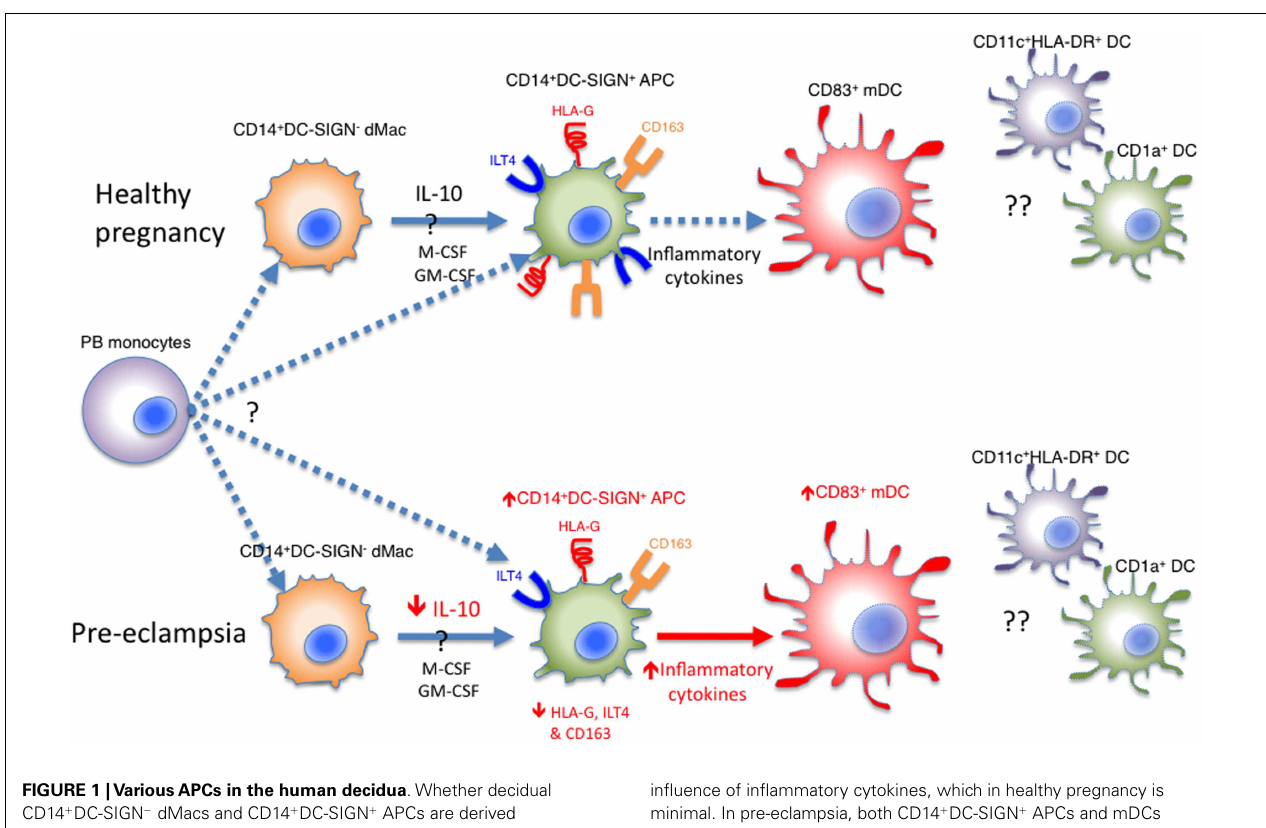
FIGURE 1 |VariousAPCs in the human decidua .Whether decidual CD14 + DC-SIGN − dMacs and CD14 + DC-SIGN + APCs are derived independently from peripheral blood (PB) monocytes is unknown. Alternatively, CD14 + DC-SIGN − dMacs may be on a continuum of DC differentiation, where local IL-10, M-CSF, and GM-CSF drive their development into CD14 + DC-SIGN + APCs expressing HLA-G and ILT4. These APCs may be matured into CD83 + mature DCs (mDCs) under the